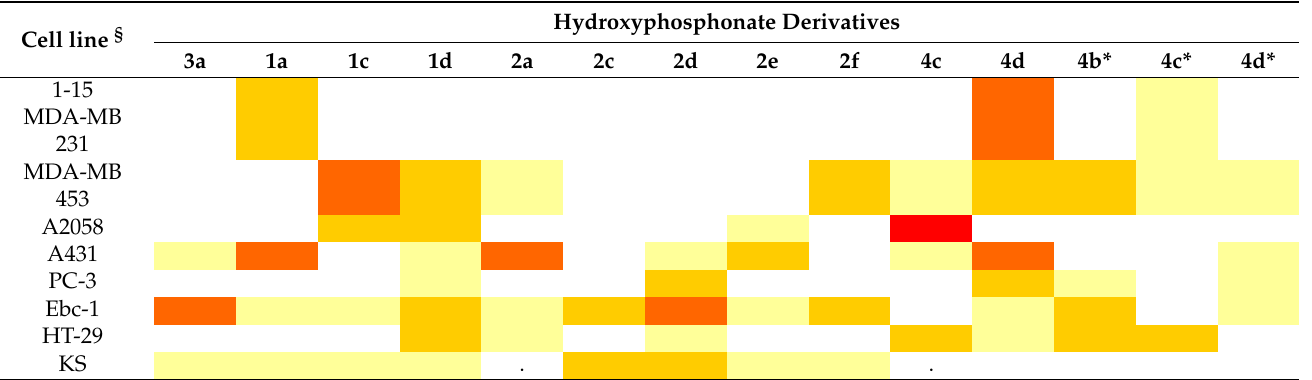
Table 5. Cytostatic effect $ of α -hydroxy-benzylphosphonate derivatives against human tumor cell lines.